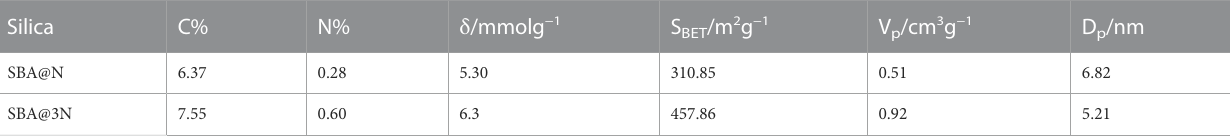
TABLE 1 Elemental analysis data: carbon and nitrogen contents (C% and N%), degree of functionality ( δ /mmolg − 1 ), surface area (S BET ), pore volume (V p ), and pore diameter (D p ) obtained with nitrogen adsorption and desorption techniques.